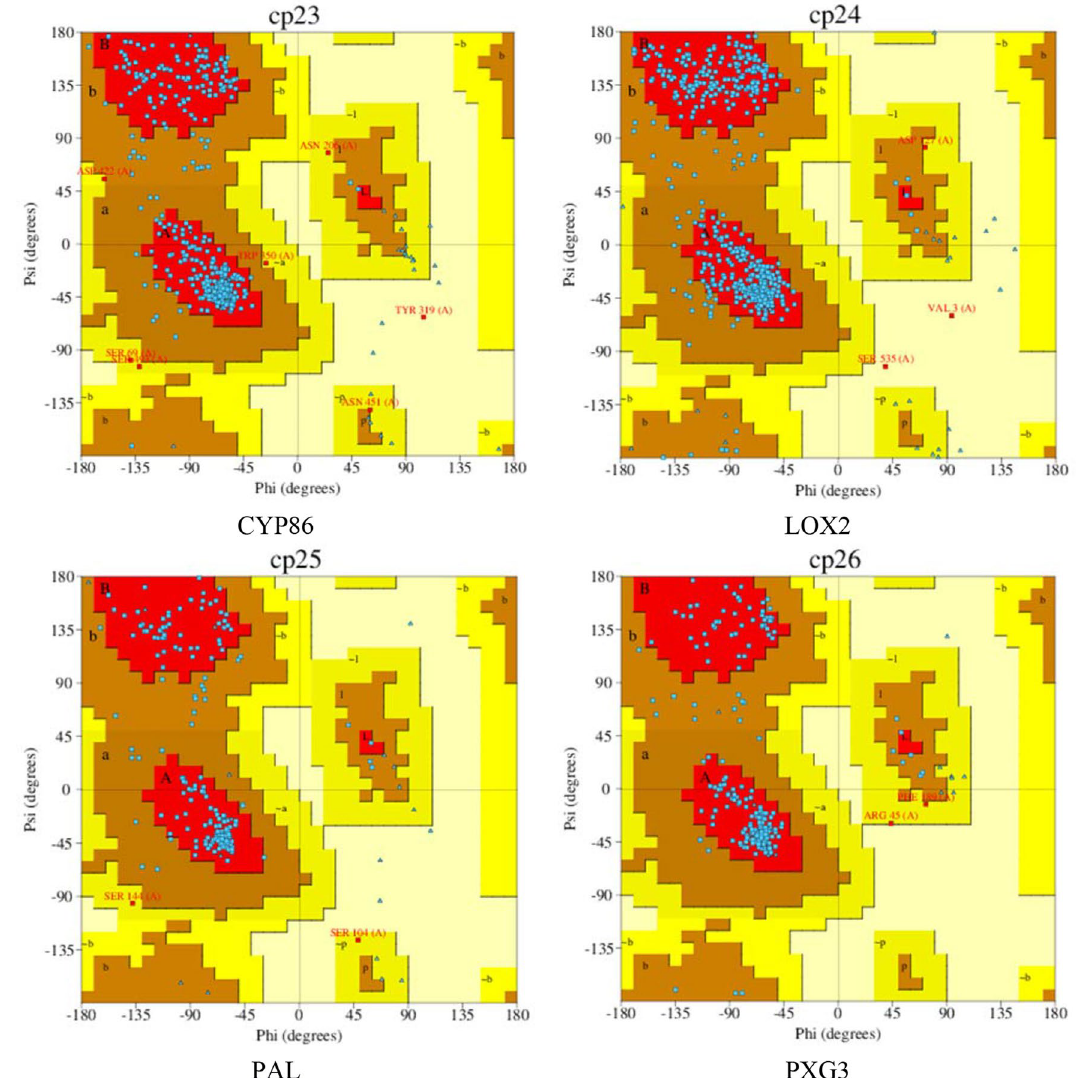
Figure 8. Ramachandran plots of the selected proteins. Most favoured regions in the Ramachandran plots are shown in red; additional allowed regions are shown in brown; generously allowed regions are shown in yellow and disallowed regions are shown in light yellow color. Blue color dots represent (φ, ψ) angles for each residue of the predicted